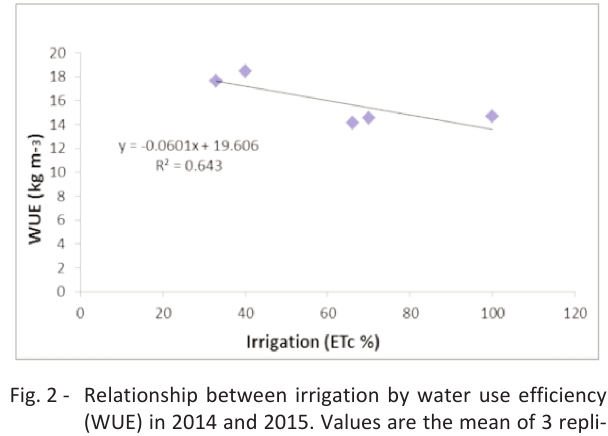
Fig. 2 - Relationship between irrigation by water use efficiency (WUE) in 2014 and 2015. Values are the mean of 3 repli- cations/10 observations each irrigation level, in two years.